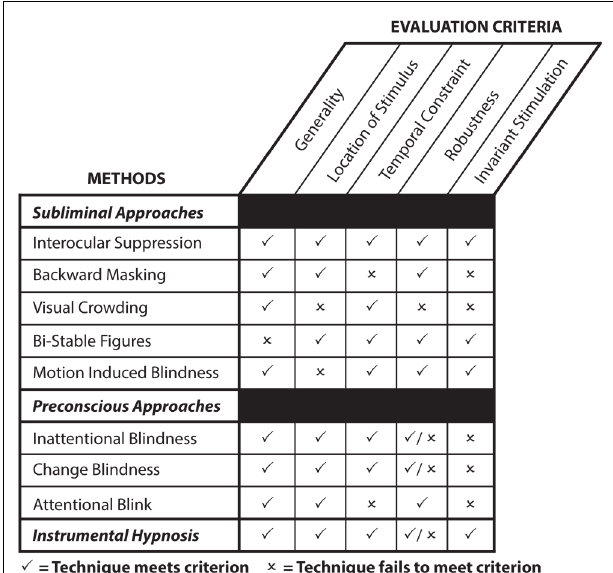
FIGURE 3 | Strengths and weaknesses of contemporary techniques to investigate unconscious perception and instrumental hypnosis as a function of evaluation criteria. Generality : whether the technique applies to a broad range of stimuli or only to a selected few. Location of stimulus : whether the stimulus has to be presented at the center or the periphery of the visual field to induce conscious suppression or inattention. Temporal constraint : whether the technique imposes a temporal constraint relative to the duration of the stimulus presentation. Robustness : whether the technique completely abolishes awareness. Invariant stimulation : whether conscious suppression requires significant modifications of sensory events to make a stimulus invisible. A “ (cid:2) ” indicates that the technique meets this particular criterion, whereas an “ × ” indicates that the technique fails to meet this particular